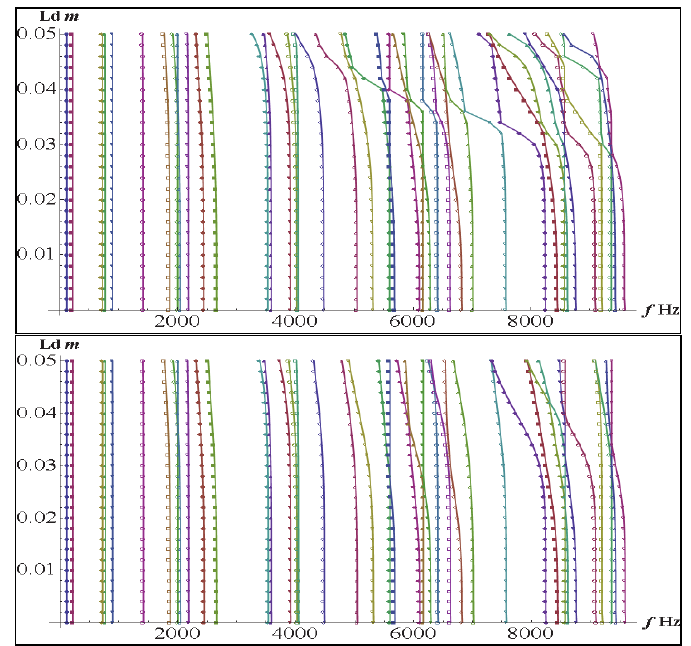
Figure 3: Shifts of natural frequencies in the range of 0-10